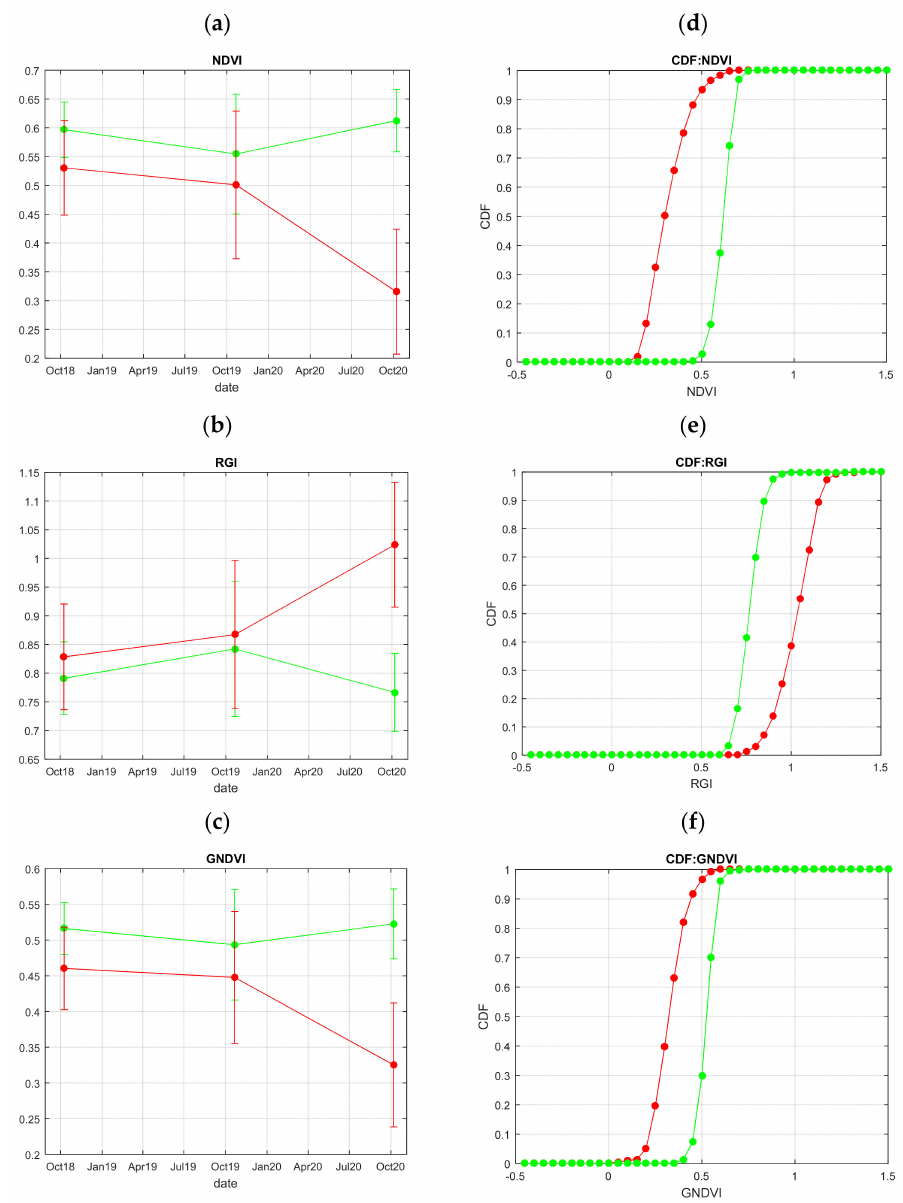
Figure 4. Healthy (green) and dead (red) trees’ temporal variability is computed based on the NDVI ( a ), RGI ( b ), and GNDVI ( c ) indices. Cumulative distribution function (CDF) applied to NDVI ( d ), RGI ( e ), and GNDVI ( f ). Green lines show the cumulative probability of healthy trees while red lines show the cumulative probability of dead